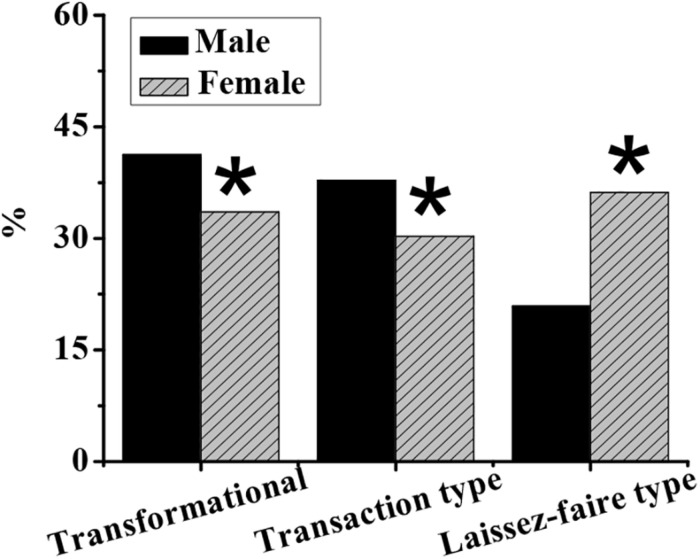
Gender differences in different entrepreneurial psychological leadership styles. Note: An asterisk (*) indicates that the difference is statistically significant compared to males (p < 0.05).